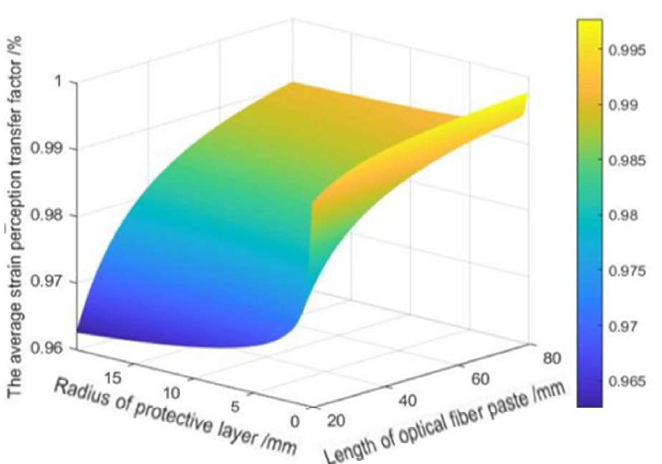
Figure 5. Effect of the length of FBG pasted and radius of the protective layer on an average strain perception transfer factor.